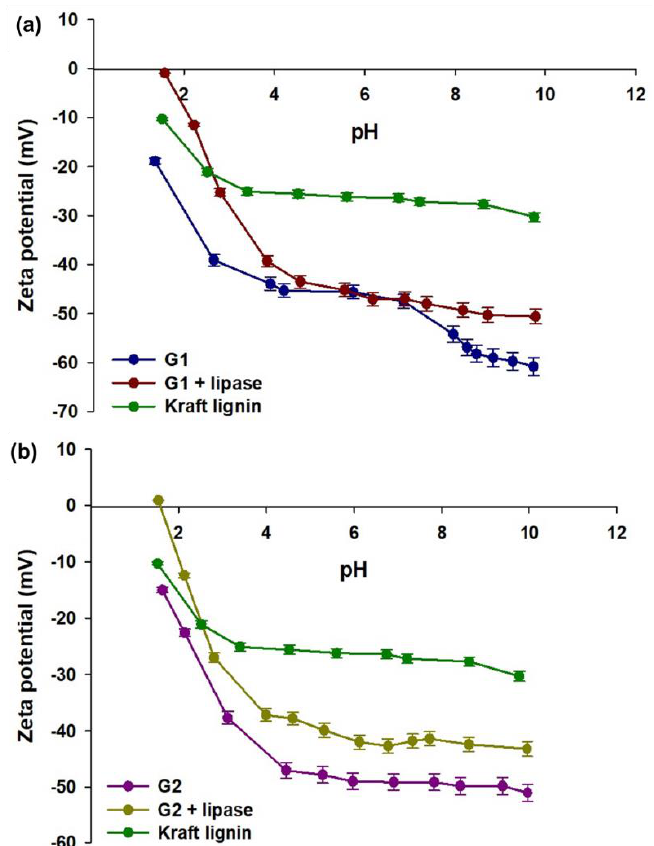
Figure 4. Zeta potential vs. pH presented for ( a ) G1 and G1 + lipase and ( b ) G2 and G2 + lipase, compared with kraft lignin. compared with kraft